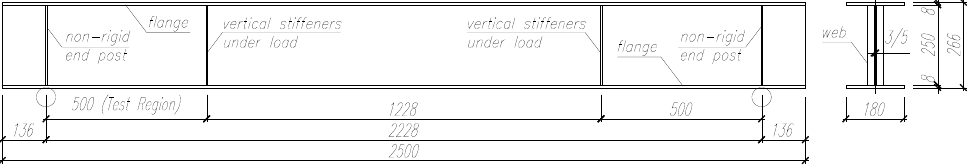
Figure 4. Parameters of experimentally tested beams (dimensions in mm).